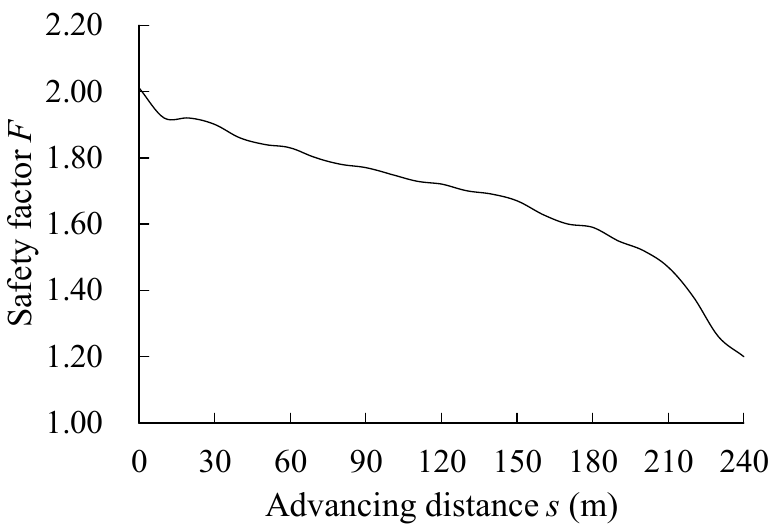
Figure 15. Relation between safety factors and working face advancing distance.